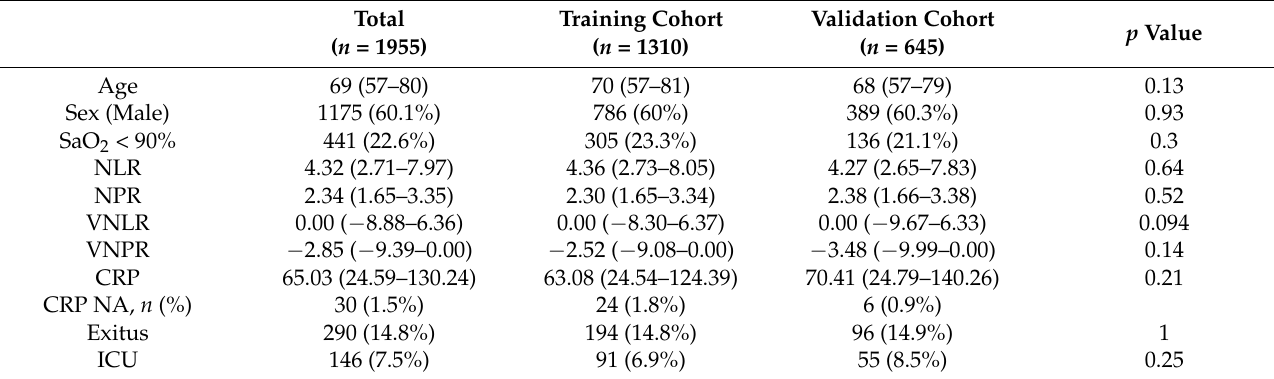
Table 1. Baseline Demographics, clinical and laboratory characteristics. Median value (interquartile